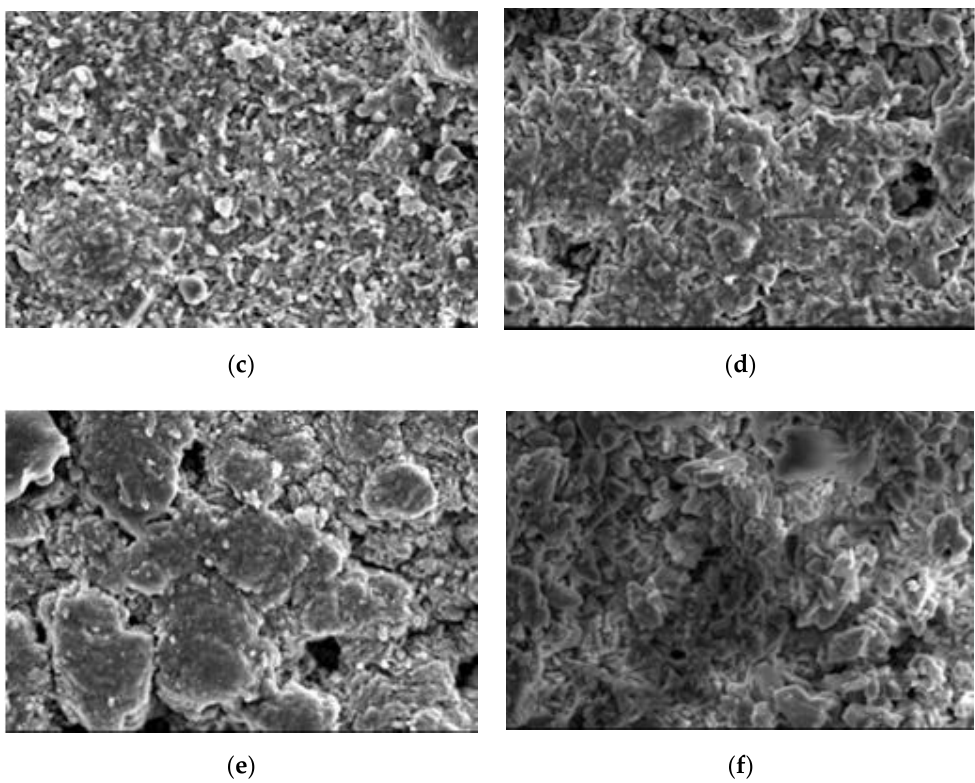
Figure 13. Typical SEM (1000 times) morphology images of cement paste at 180 days: ( a ) 20–50,000; ( b ) 40–90,000; ( c ) 70–0; ( d ) 70–2000; ( e ) 70–7000; and ( f ) 70–180,000 ppm.